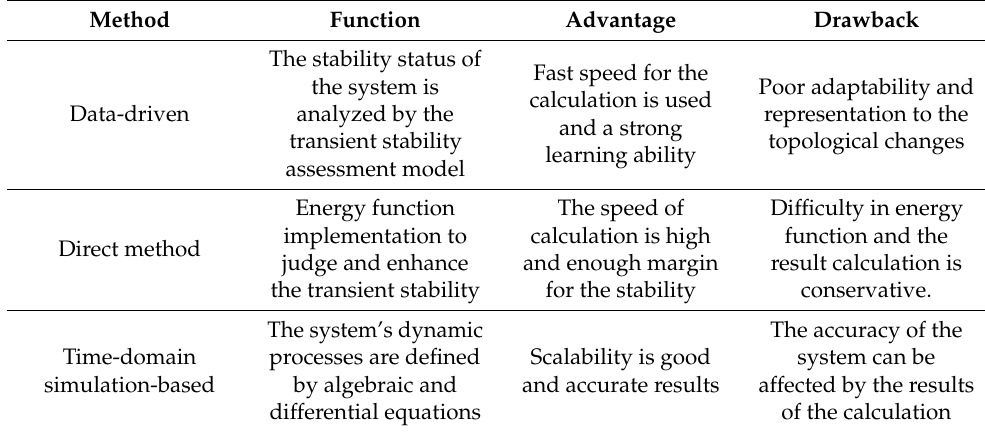
Table 1. Methods in transient stability